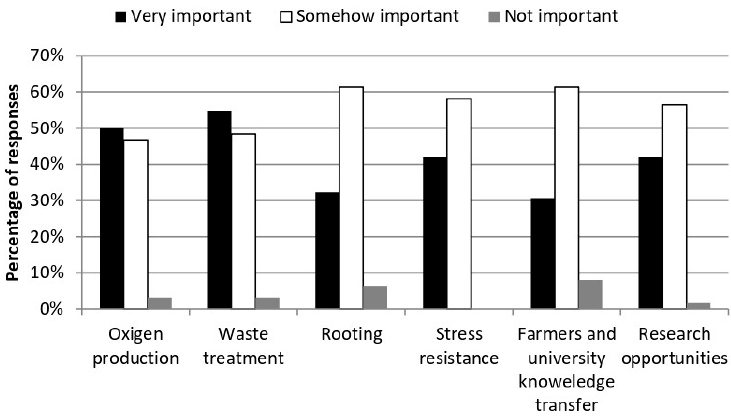
Figure 4. Farmers’ knowledge of specific microalgae applications in Almería’s agriculture.